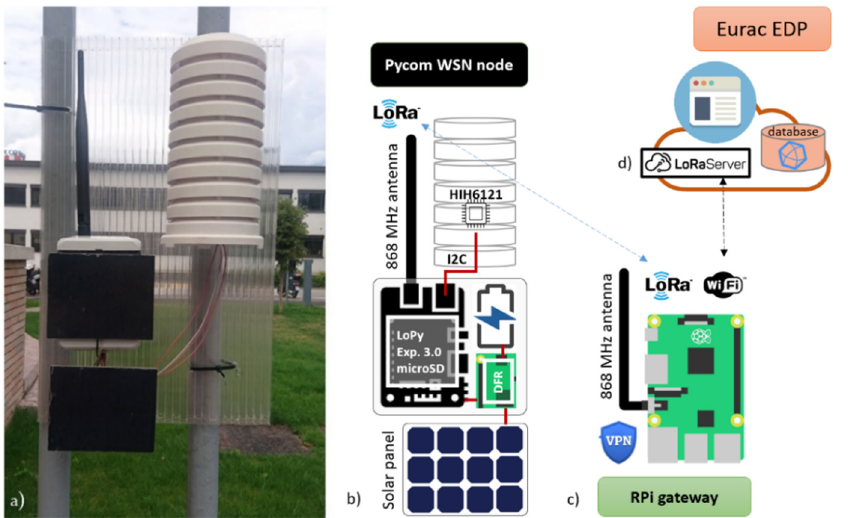
Figure 2. ( a ) Picture of one sensor node; ( b ) building block schematics of the sensor-node; ( c ) Lo- RaWAN gateway that forwards the data packets from the sensor nodes to the EDP; ( d ) EDP com- ponents that allow the proper management of the network.